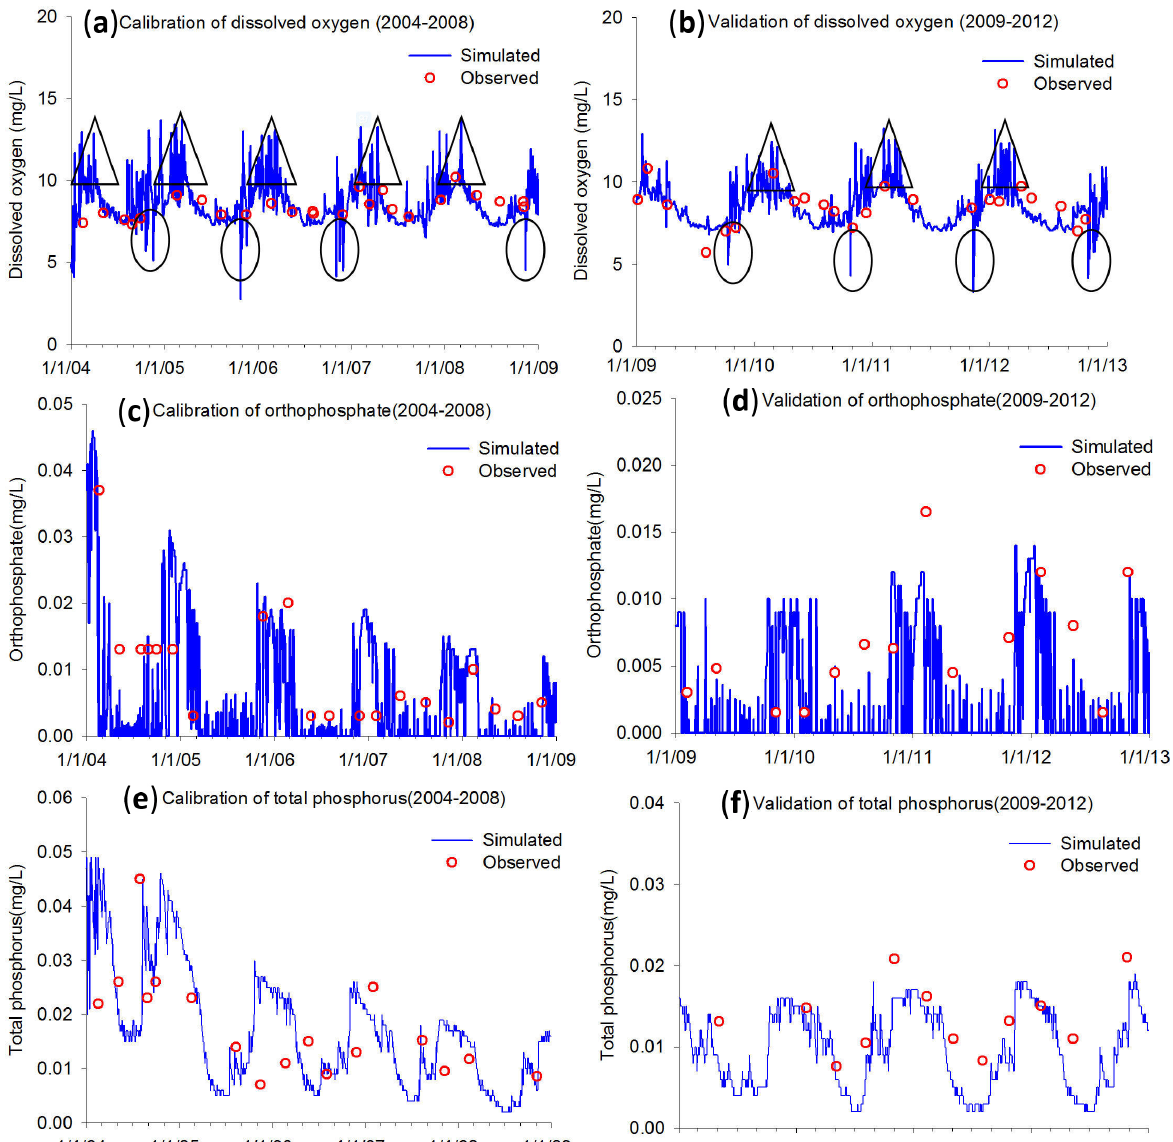
Figure 6. The calibration and validation results of W2 simulated water quality parameters at surface layer of segment 3. Sub-figures show the comparisons between W2 simulation results to: observed DO concentrations during ( a ) calibration and ( b ) validation periods; observed ortho-P concentrations during ( c ) calibration and ( d ) validation periods; and observed TP concentrations during ( e ) calibration and ( f ) validation